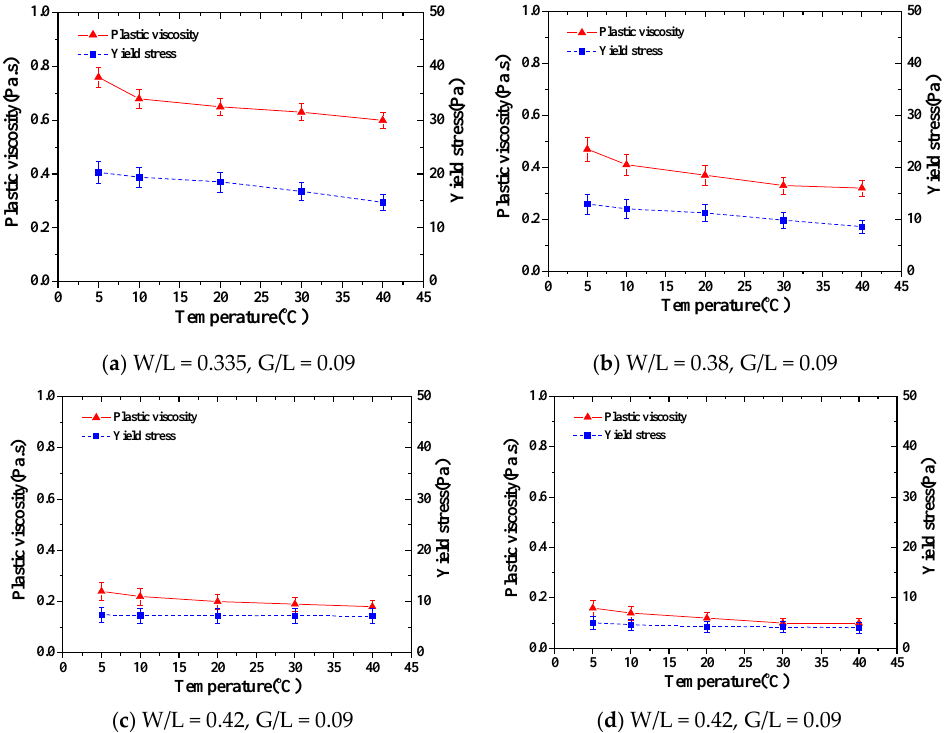
Figure 5. The rheological parameters for standard reference materials by mixing ratios.